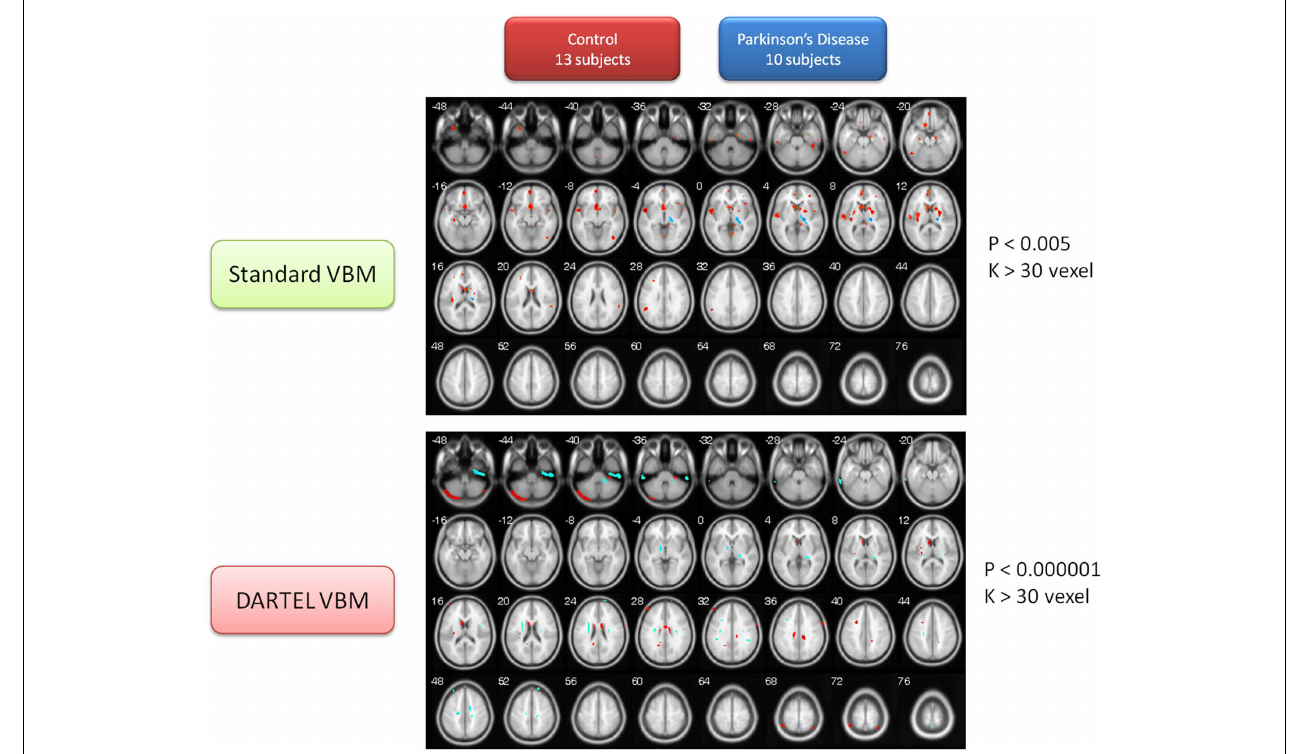
cortex, and several occipital regions.The DARTELVBM method with a critically significant-level also demonstrated the basal ganglia atrophy in PD patients, but the other atrophy regions are not totally consistent with the observation using basicVBM method. Conversely, the two methods consistently pinpointed that the posterior part of thalamus in PD patients is larger than that of normal